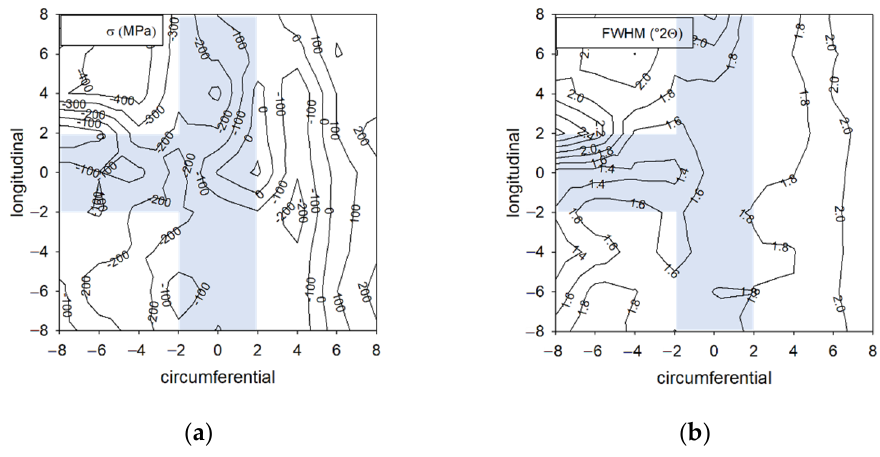
Figure 10. Maps of the ( a ) macroscopic residual stresses and ( b ) FWHM parameter of the crossing area of the longitudinal and circumferential welds of the pressure vessel (blue area). The analysis direction is perpendicular to the circumferential weld [22].